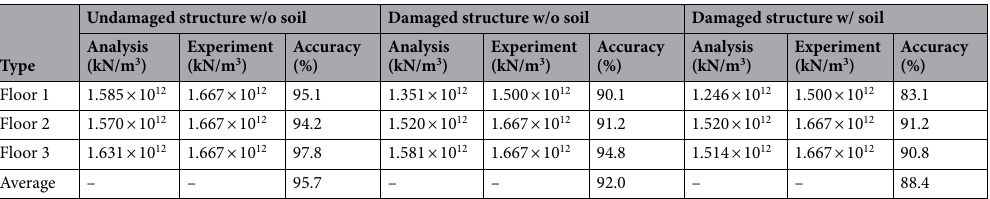
Table 5. Comparison of floor stiffness between model updating and experiment